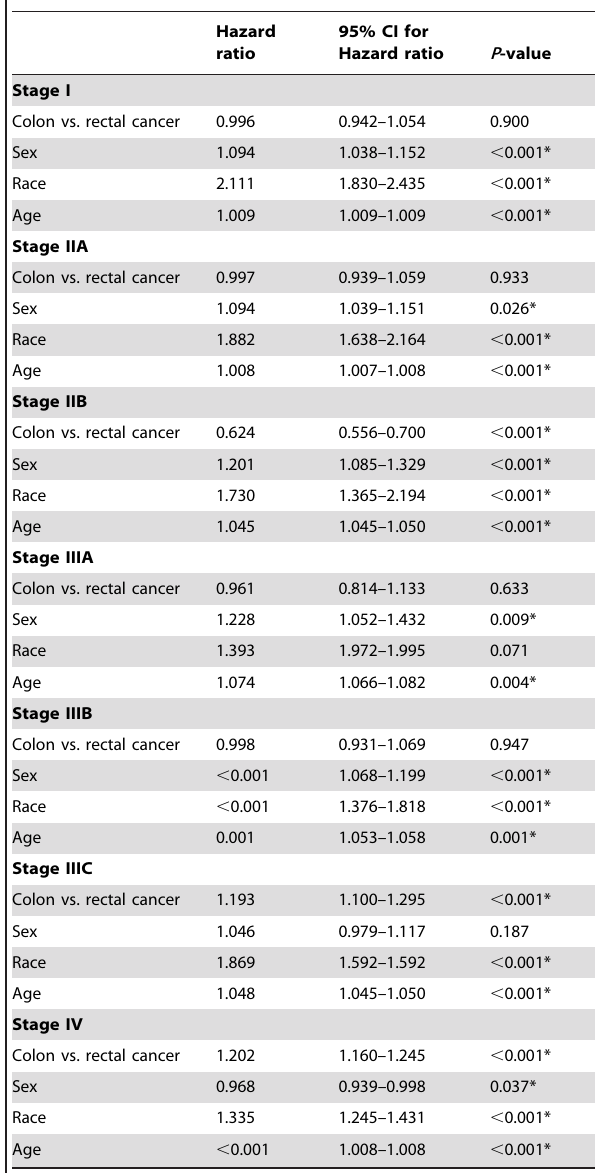
Table 5. Cox’s regression for colorectal cancer.